Question: What form of chart is displayed?
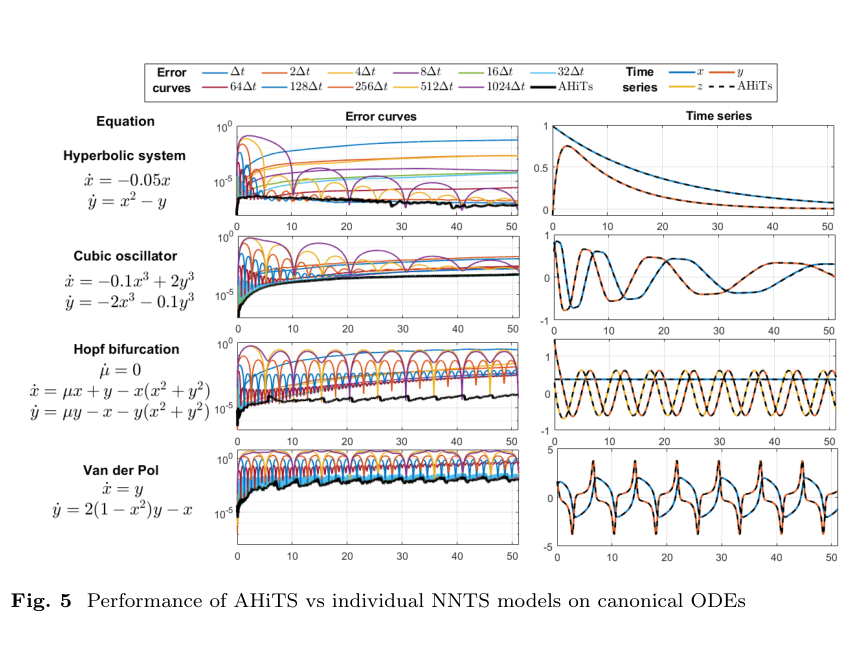
Answer: line